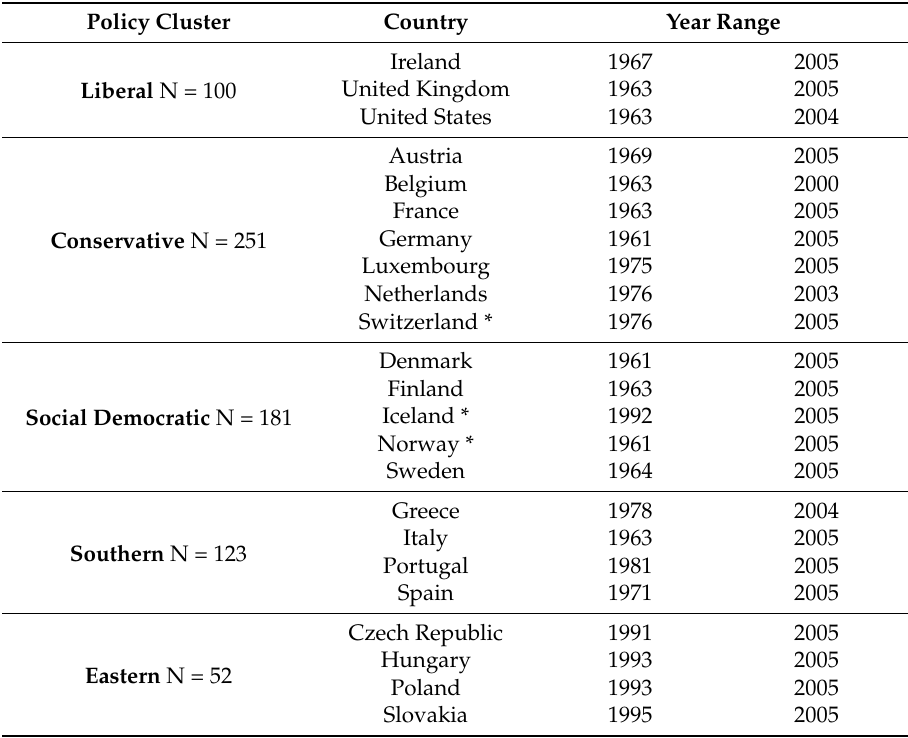
Table 1. Countries and Policy Clusters.